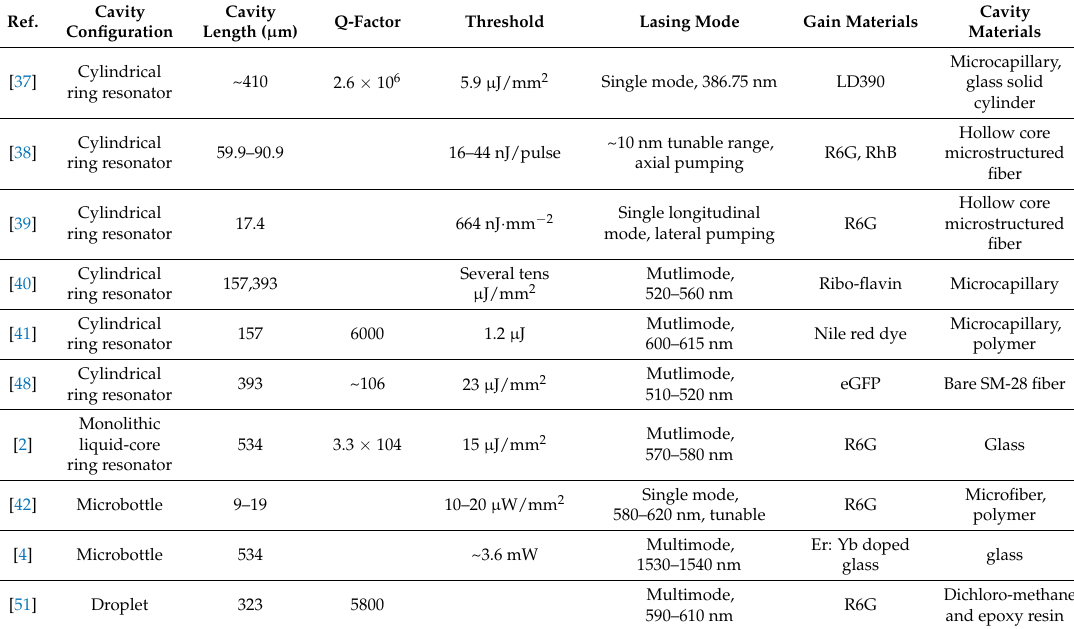
Table 2. List of the optofluidic lasers based on the WGM microcavities.